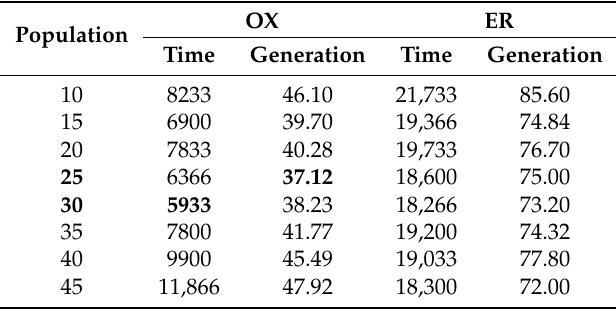
Table 1. Results of different crossover methods: Ordered Crossover (OX) and Edge Recombination (ER). Elitism was 15 and Mutation Rate 1%.